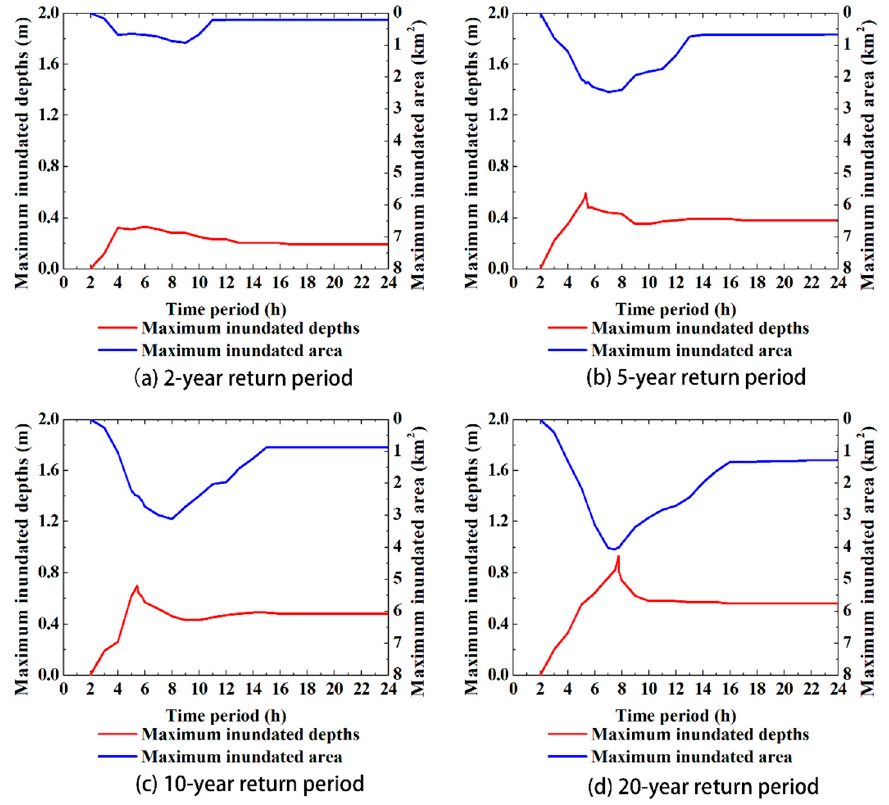
Figure 5. Maximum flooding depths and areas.